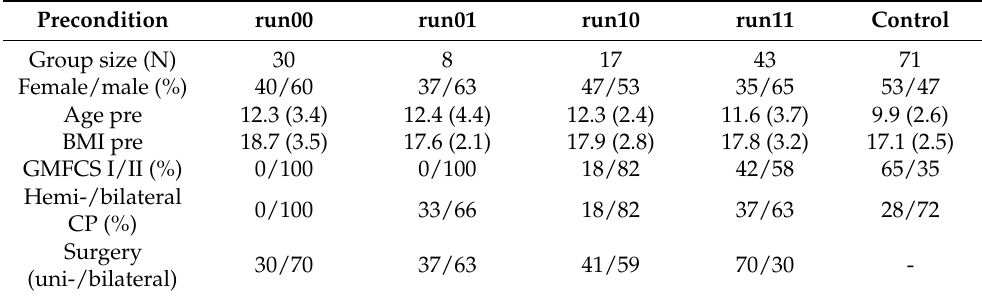
Table 1. Patient characteristics.